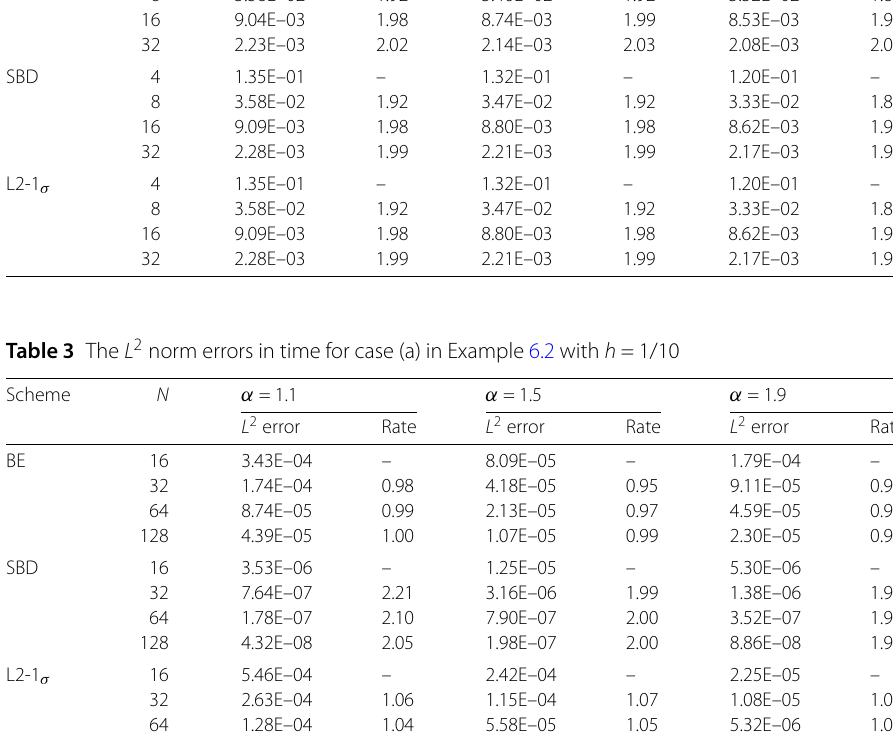
Table 2 The L 2 norm errors in space for Example 6.1 with N = 4096 Scheme BE